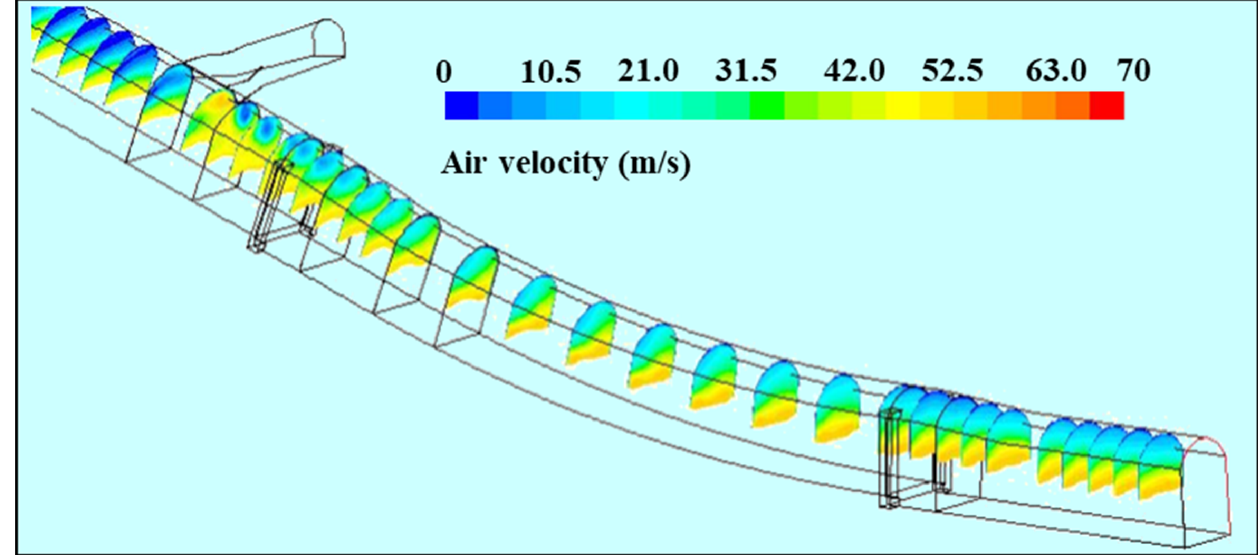
Figure 11. The regions of residual space along the tunnel and the contours of air velocity on it.